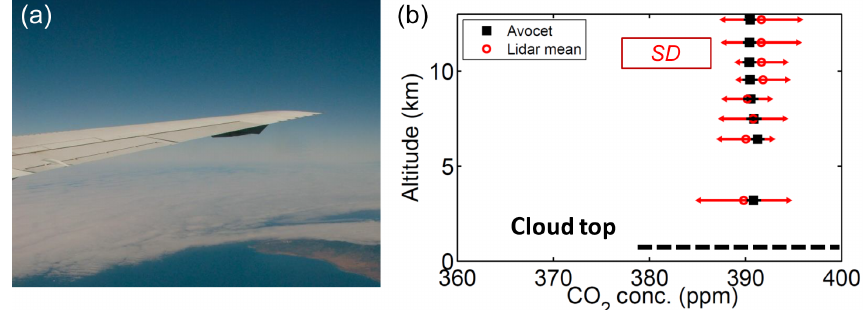
Figure 8. (a) Photo of marine stratus cloud deck over the Pacific Ocean near the California coastline taken on the ASCENDS flight on 2 August 2011. (b) The retrieved values of XCO 2 to the cloud tops at altitudes of 700m (black dashed line) as a function of flight altitude. The XCO 2 values integrated from the in situ AVOCET gas analyzer are marked in black squares, and the retrieved values from the CO 2 Sounder for 10s average are marked in red circles. The error bars for the retrieved XCO 2 are for ± 1 standard